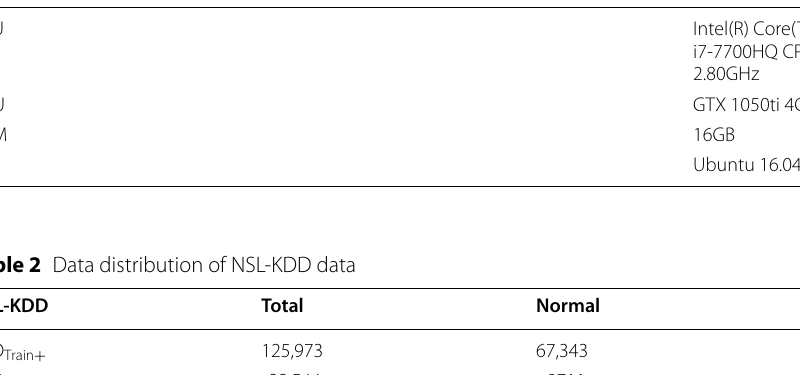
Table 1 Environment of the experiment